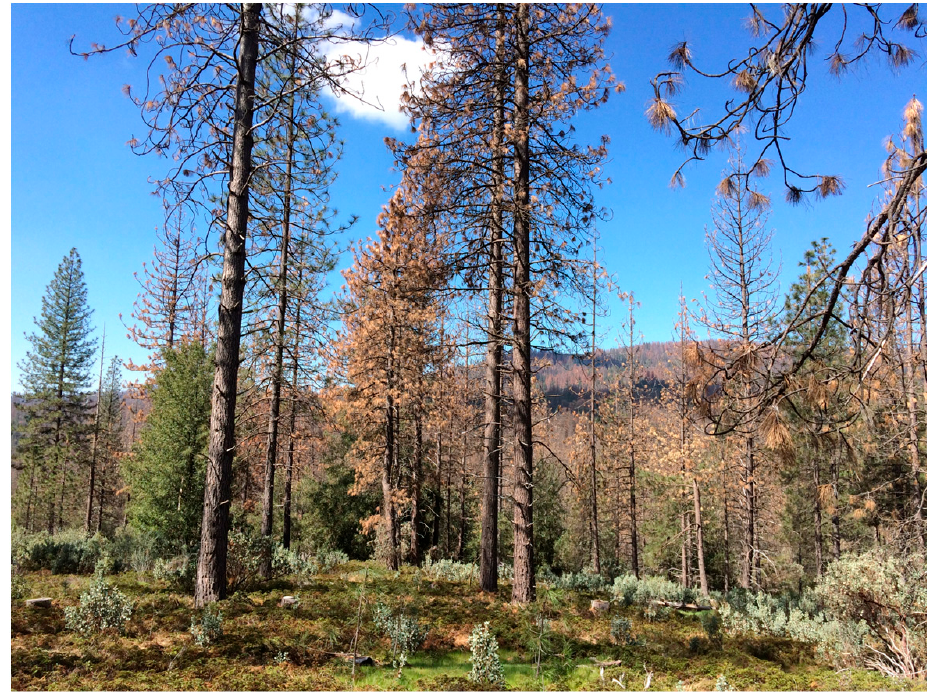
Figure 1. Tree mortality in the Sequoia National Forest, California, 2017. Most of the faded trees were colonized and killed by western pine beetle ( Dendroctonus brevicomis ) in 2016. Photo credit: C.J. Fettig, USDA Forest Service.